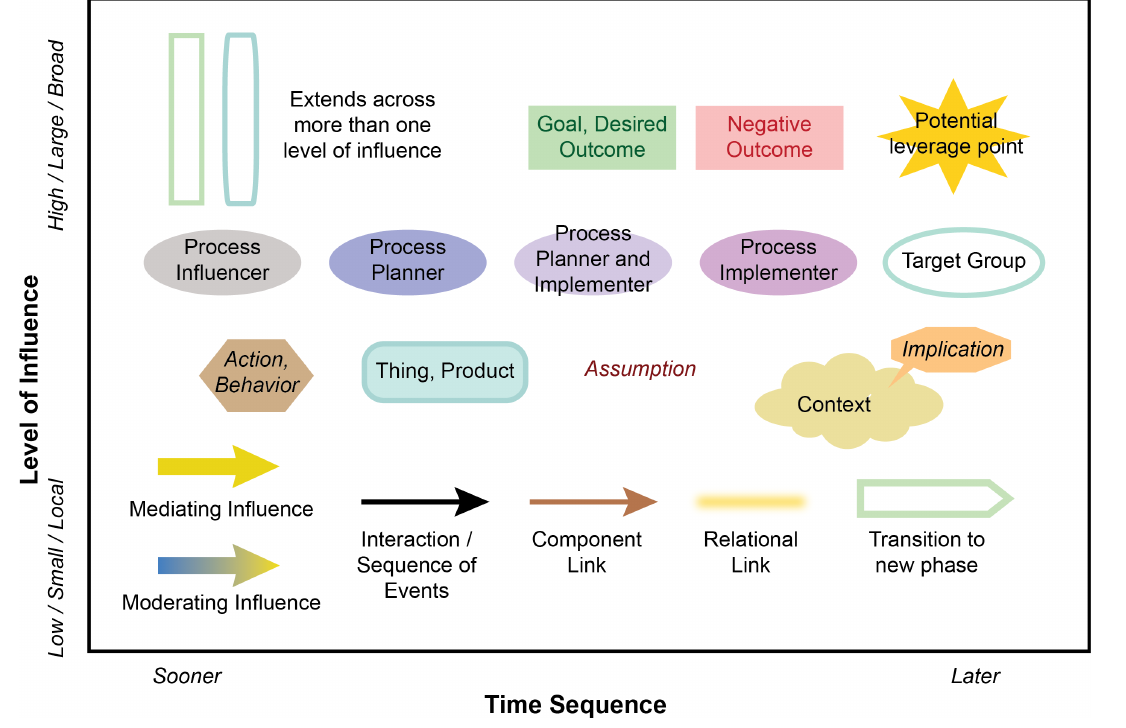
Fig. 1 . Symbol key based on the categories listed in Tables 2 and 3. Conceptual models built using these symbols can display contextualized causal relationships within a problem system in a way that is useful for project